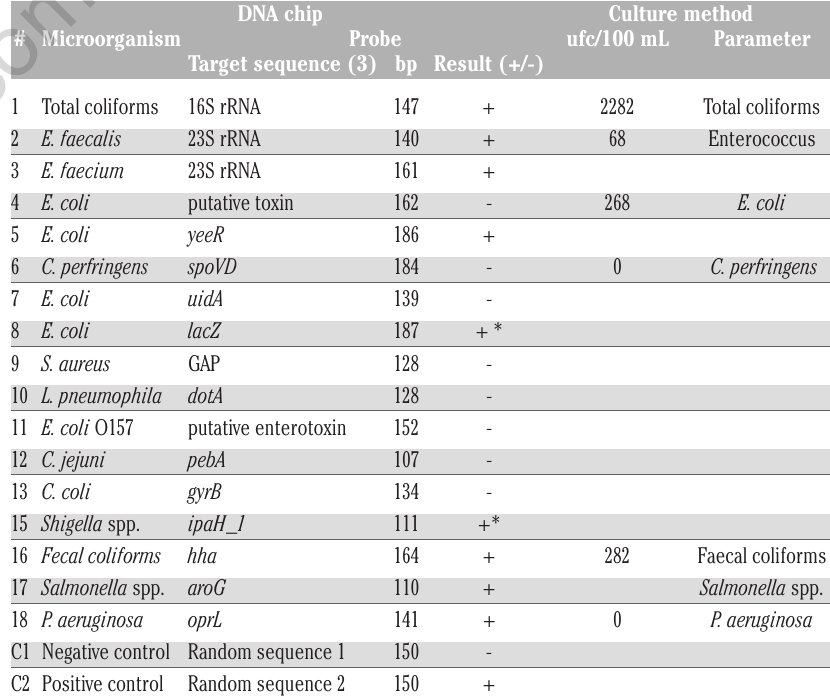
Table1. Results obtained by the DNA chip and culture method for the untreated water